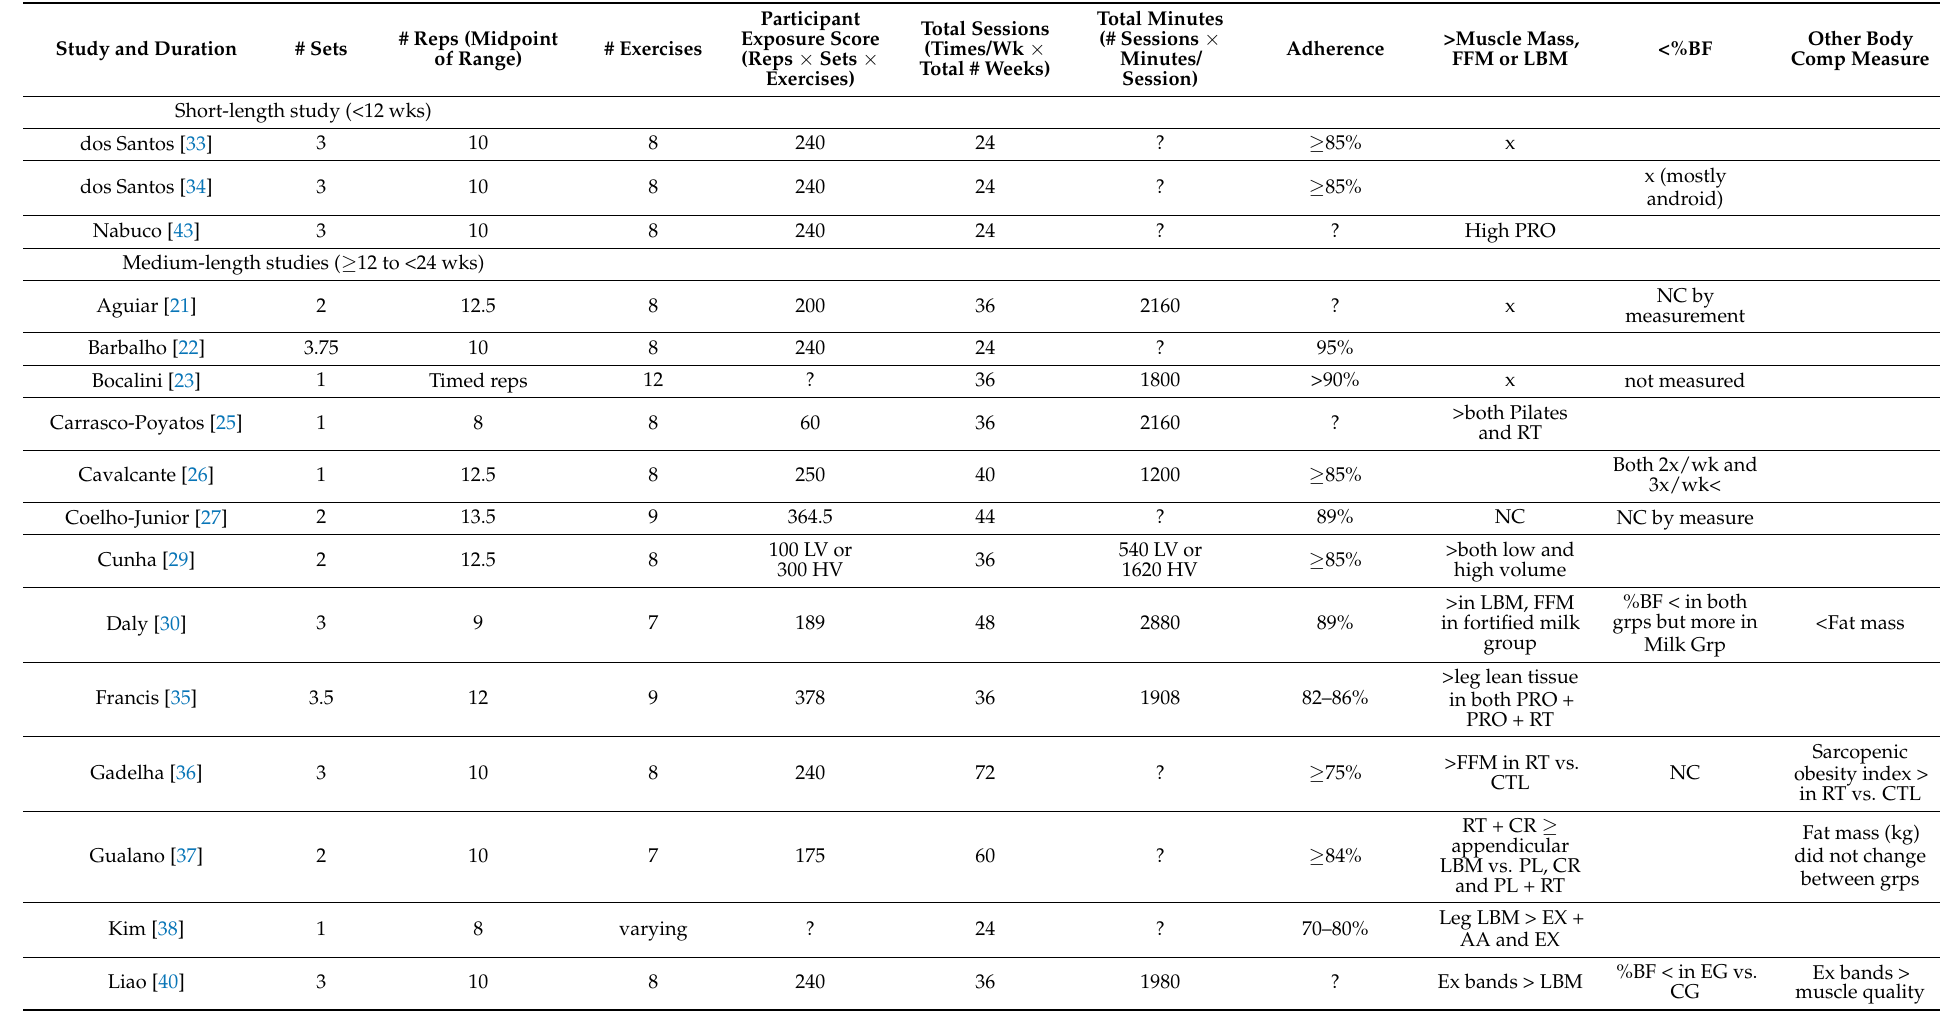
Table 4. Summary of impact of participant exposure, study duration, and adherence in studies that measured body composition in older women. Study and